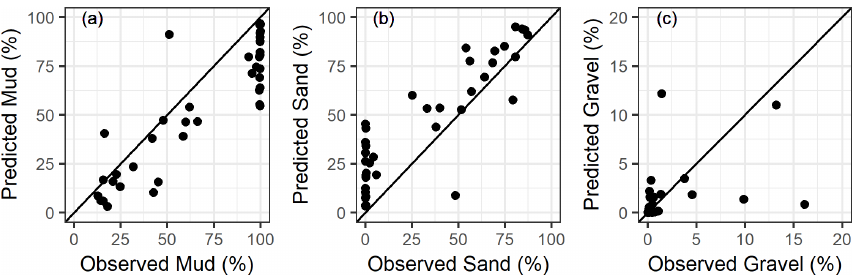
Figure 8. Comparison of predicted and observed percentages of (a) mud, (b) sand, and (c) gravel in Firth of Clyde seabed sediments. Observation data are recent measurements carried out in 2017 that were not used during model fitting. Predictions were generated from the sediment maps presented in Fig. 7. This is therefore an independent test of model and map predictive performance.